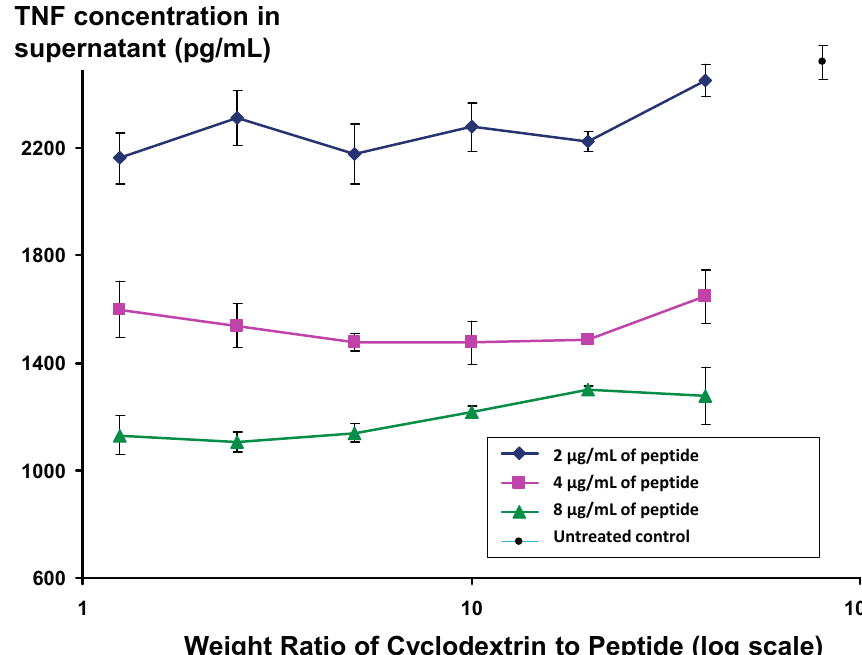
Figure 5. Changes in level of secretion of TNF into the supernatant of LPS-stimulated J774A.1 cells overnight after exposure to Lex 2.6 formulated with beta hydroxypropyl cyclodextrin at different ratios to peptide by